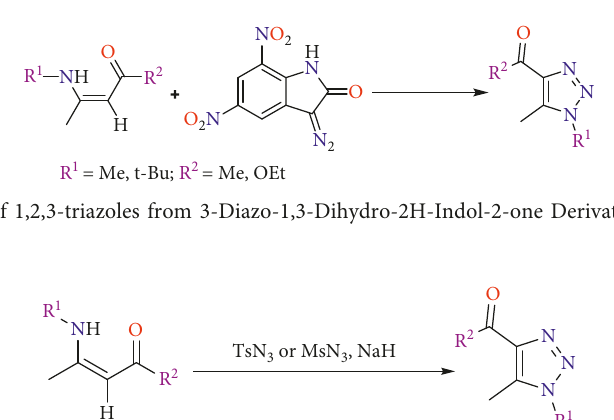
Scheme 6: Synthesis of 1,2,3-triazoles from Dichloro or Trichloroacetaldehyde Sulfonyl-Hydrazones with Primary Amines.